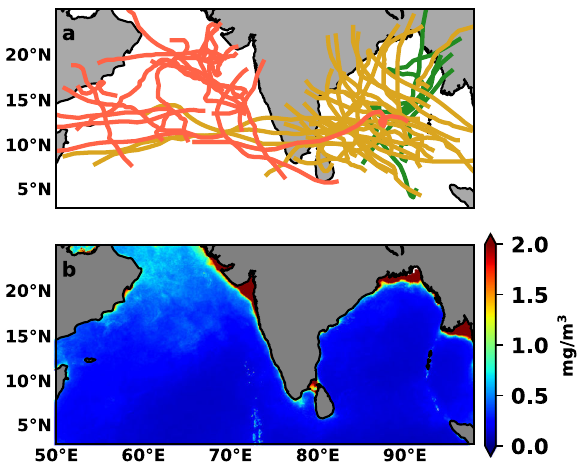
Fig. 1 The cyclone tracks and pre-cyclone background Chl-a value. a The study region North Indian Ocean (NIO) and the tracks for the pre- (green) and post-monsoon (yellow) cyclones for BoB and AS (red), as analysed for all cyclones occurred during the study period (1997 – 2019).